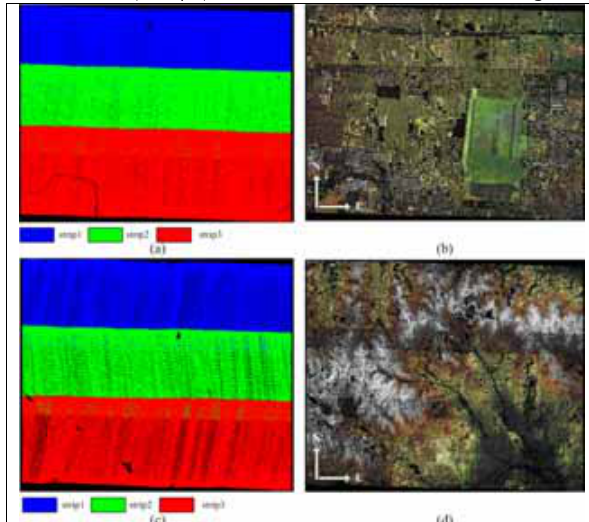
Figure 4. Two groups of LiDAR raw data sets: (a)~(b) Hebei data set of urban scene, (c)~(d) Henan data set of mountainous area.